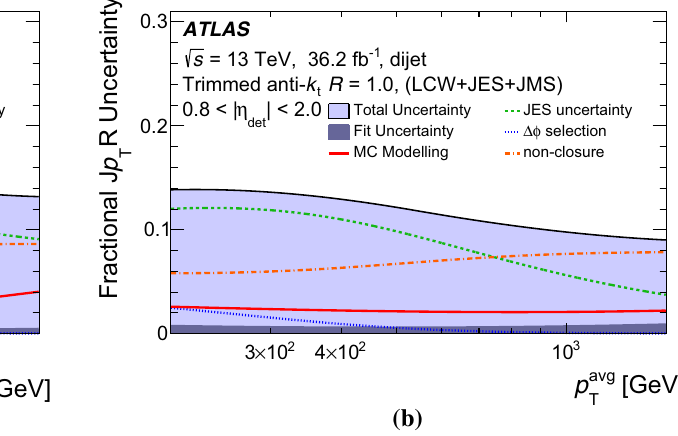
Fig. 24 The relative uncertainty in the ratio of the jet transverse momentum p T resolution measured in dijet events and in simulations as a function of the average jet p T in pseudorapidity η bins a | η | < 0 . 8 and b 0 . 8 < | η | < 2 . 0. The large- R jet p T is corrected using the simulation calibration, η -intercalibration, and a combination of in situ